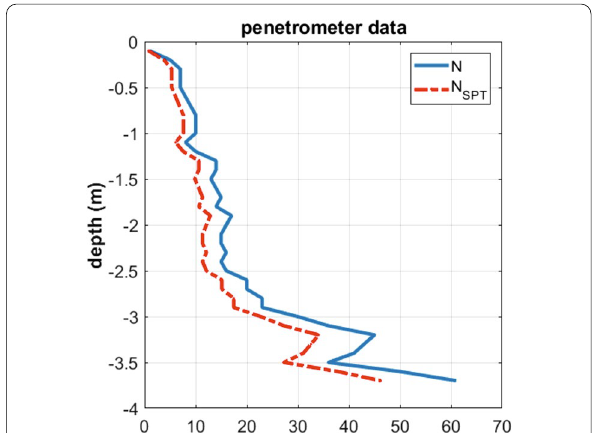
Fig. 5 San Marco dune, penetrometer data at P1 (see map in Fig. 2b). N is the number of blows to make the cone penetrate by 10 cm while using a 10 kg weight dropping from a 30 cm height, while N SPT are the values converted to the Standard Penetration Test according to the specifications of the manufacturer. The penetrometer test stopped (refusal) at a depth of about 3.7 m because of a very hard